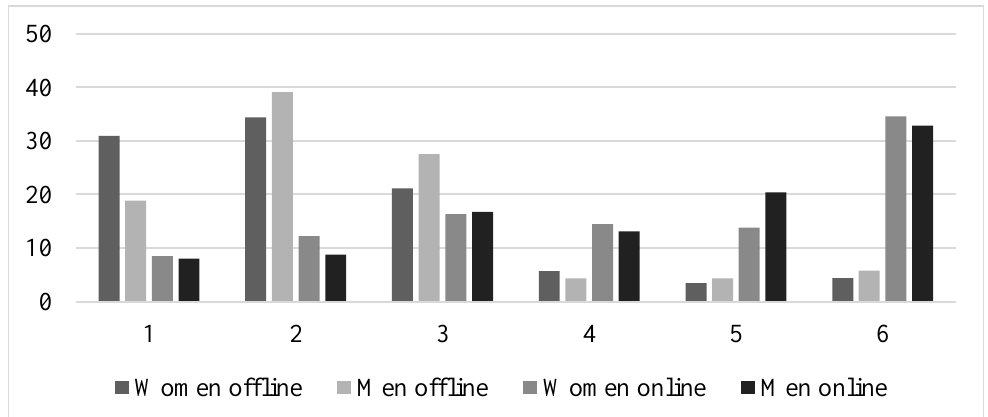
Fig. 3. Distribution of evaluations of online and offline networks by gender to the employment